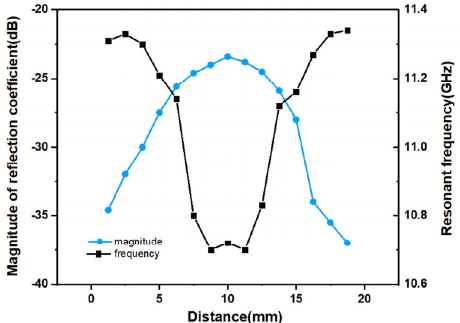
Figure 15. The measurement results of one-dimensional direction for abnormal tissue detection.